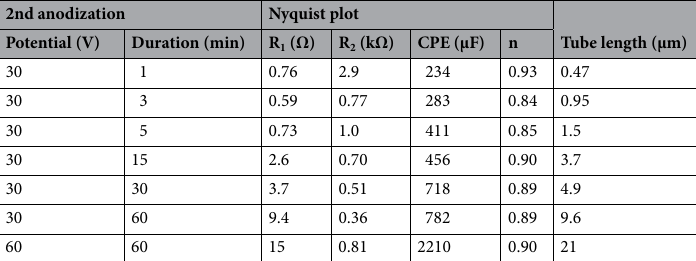
Table 3. Parameters obtained from EIS